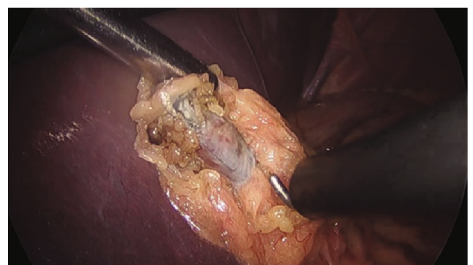
Figure 2: Laparoscopic image of an in fl ammatory capsule surrounding the migrated Filshie clip during